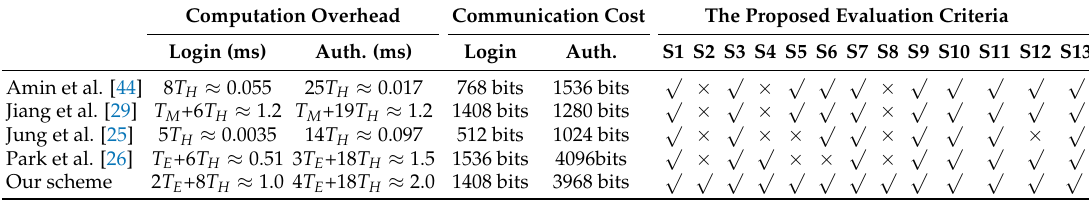
Table 3. Performance comparison among relevant schemes in wireless sensor